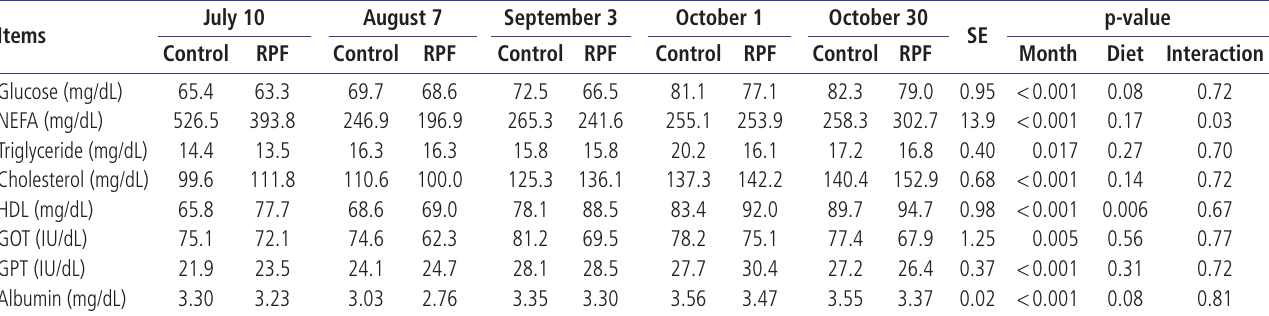
Table 5. Serum parameters of Korean cattle steers fed either control or RPF–supplemented diet during July through October of 2015 (before feeding)